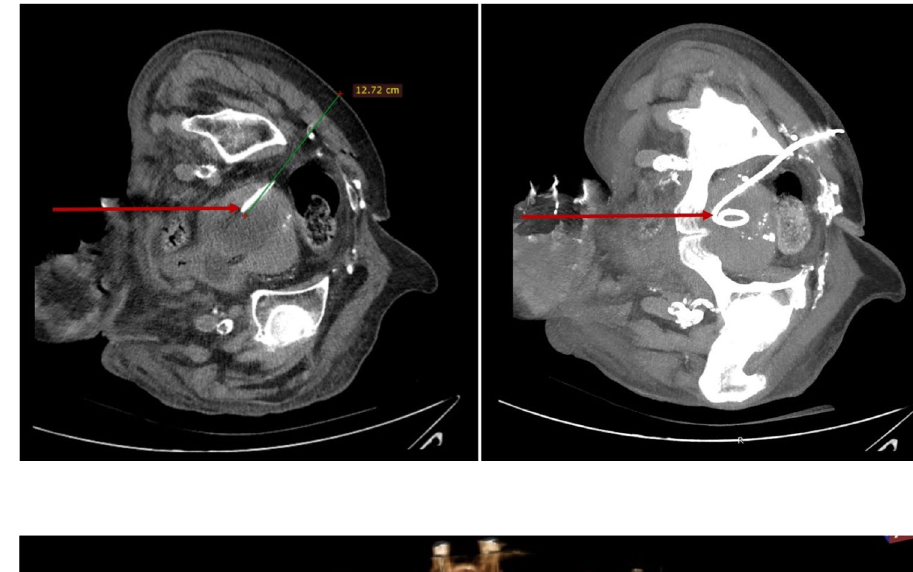
Fig. 6 Three-dimensional reconstruction of the bony pel- vis with the catheter in place